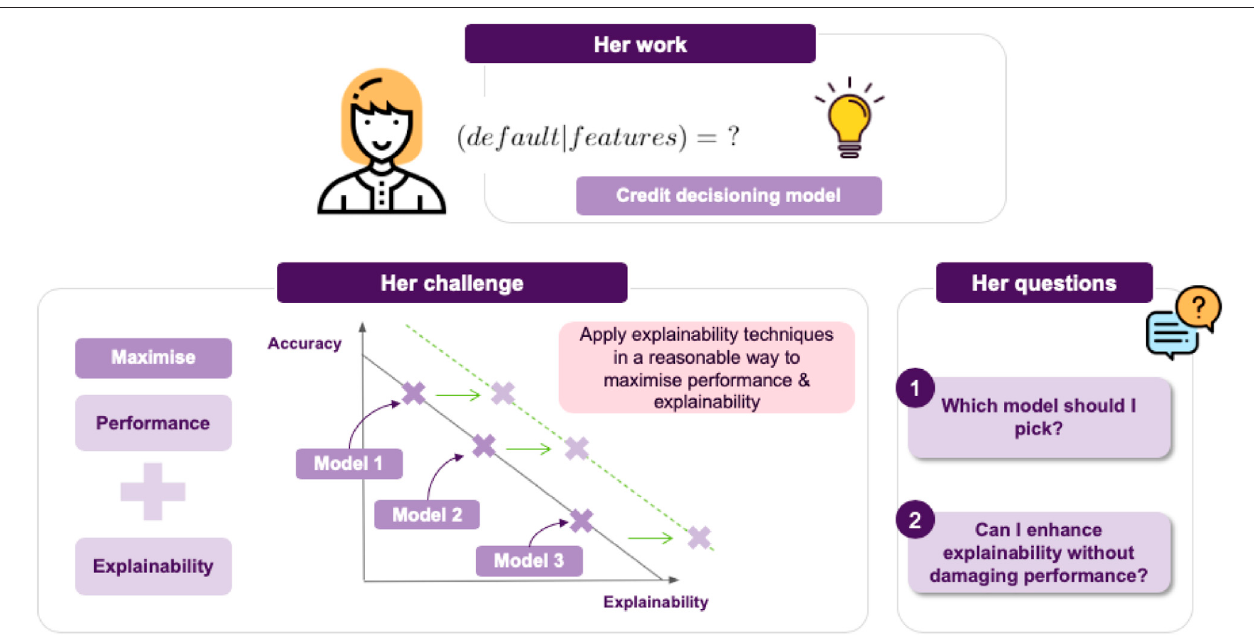
FIGURE 3 | Jane ’ s agenda and challenge: which model offers the best trade-off in terms of accuracy vs. explainability?